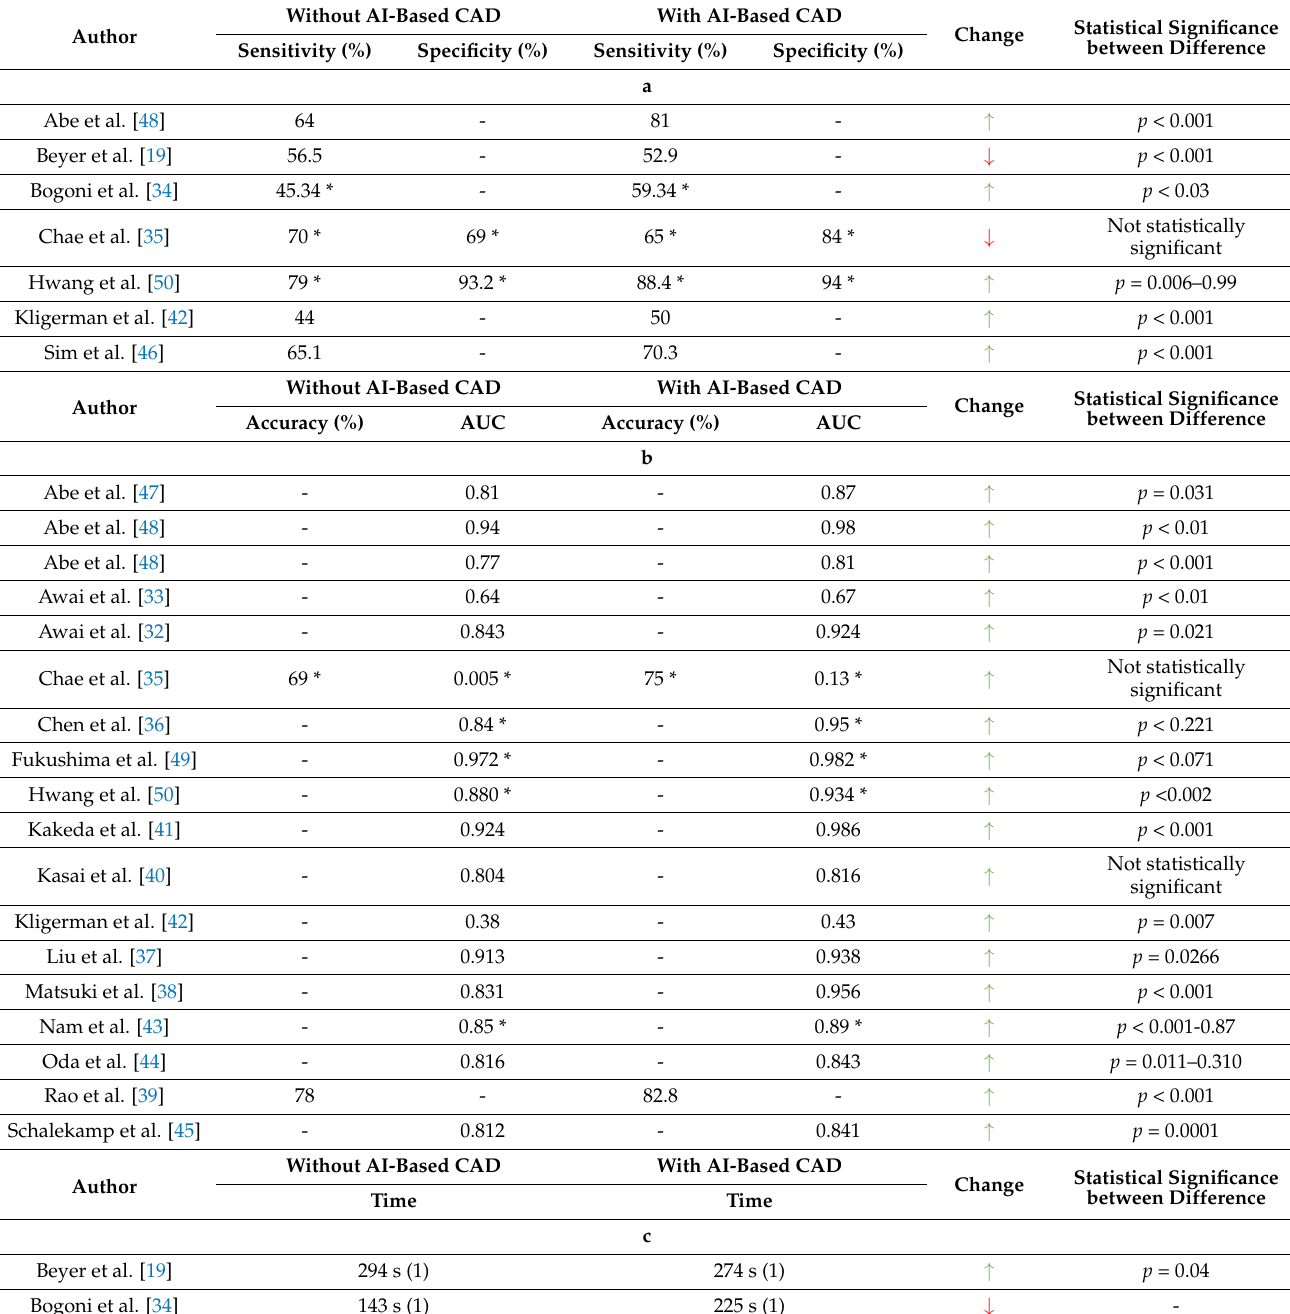
Table 3. Sensitivity and specificity ( a ); accuracy and AUC ( b ); and time measurement results ( c ) for sequential observer tests without and with AI-based devices as a second